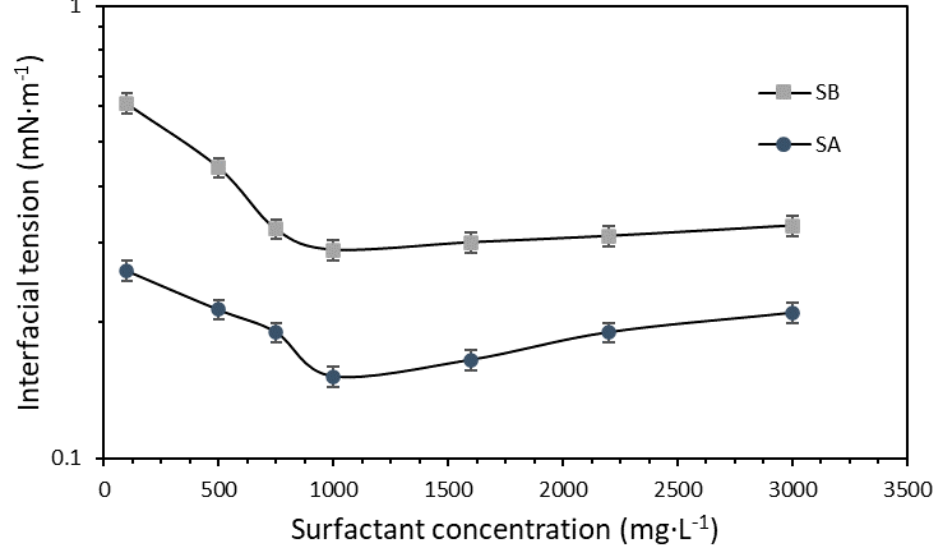
Figure 6. Interfacial tension measurements for surfactants SA and SB in synthetic brine. The tests were conducted at 50 °C, varying the surfactant dosage between 100 and 3000 mg·L − 1 . The symbols represent the experimental data, and the error bars correspond to their standard deviation.